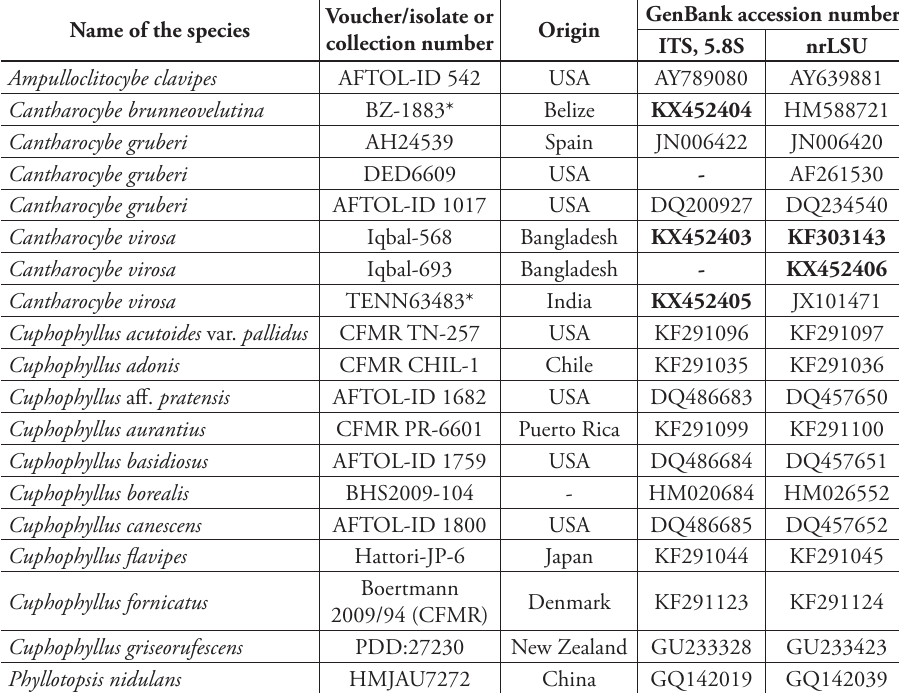
Note: Newly generated sequences are highlighted in bold. An asterisk (*) at the isolate indicates holotype